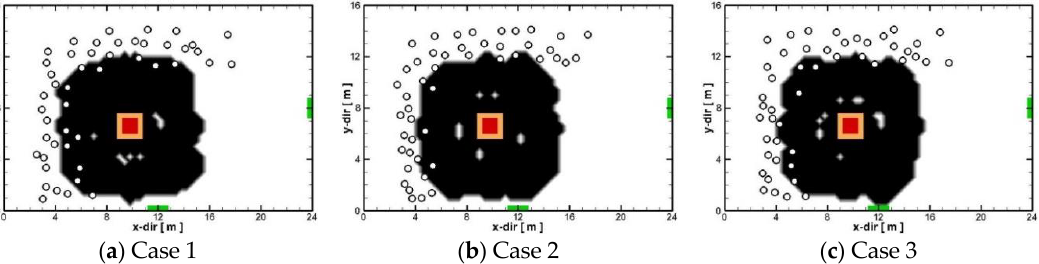
Figure 3. The distribution of the evacuees at 4 s.